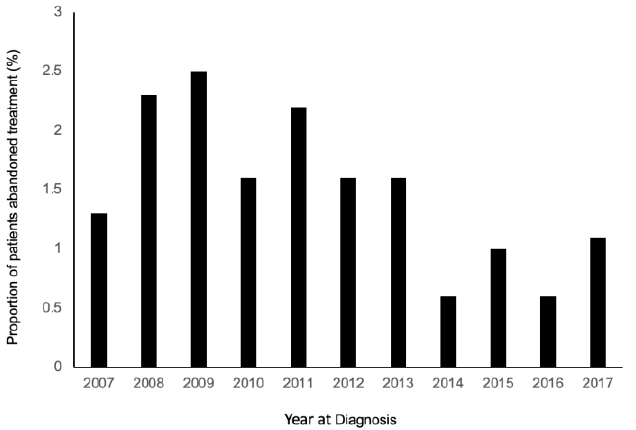
Figure 1. Proportion of patients who abandoned treatment by year of diagnosis from 2007 to